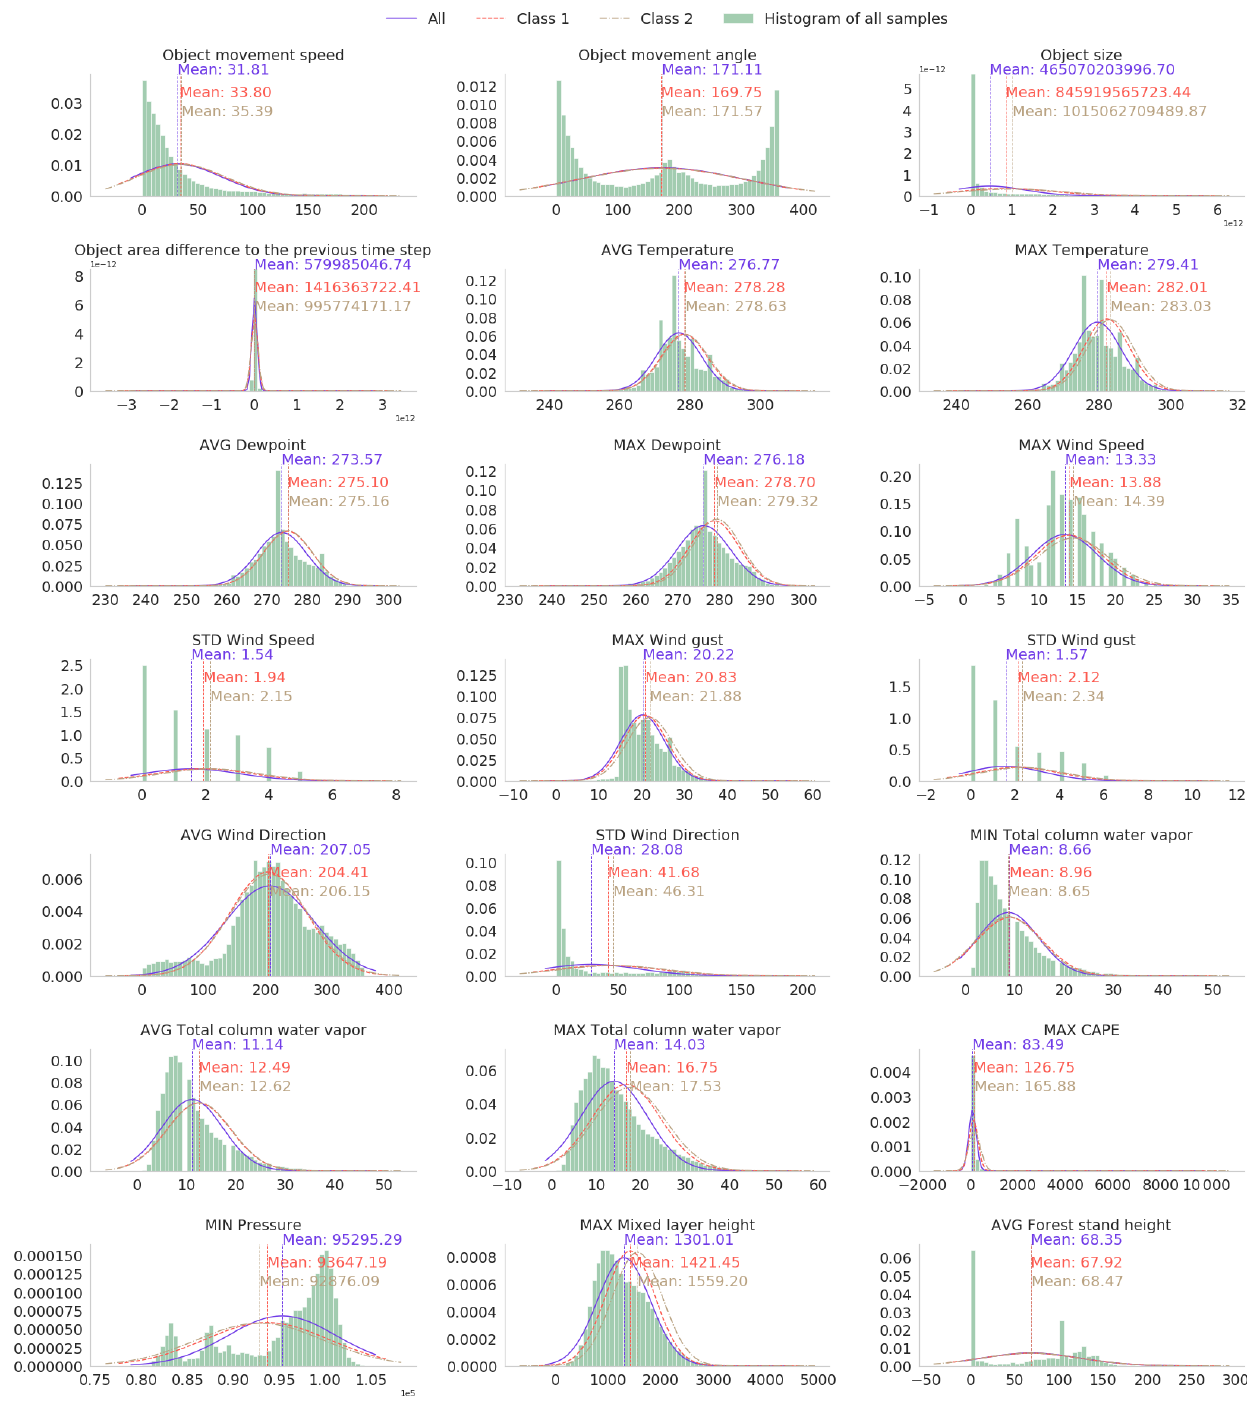
Figure A2. Histogram of and fitted Gaussian distribution of selected predictive parameters in the national dataset. The Gaussian distribution is fitted separately to all samples and samples with little outages and many outages (classes 1 and 2 specified in Sect.